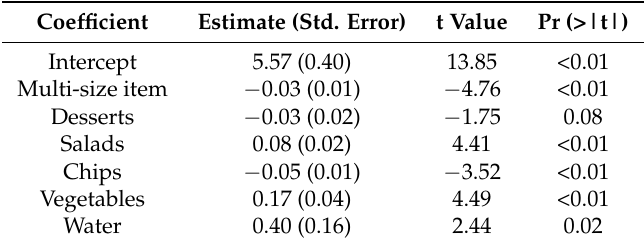
Table 2. Significant coefficients from the generalized linear model associated with the nutrition researchers’ cumulative health score, reporting each independent variable’s estimate, standard error, t -test, and p -value.